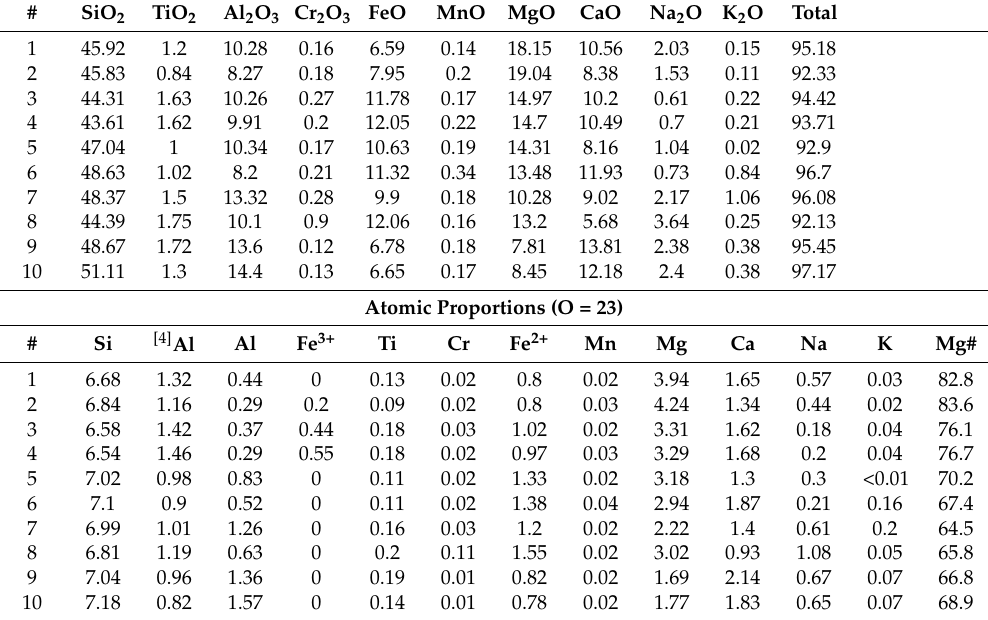
Table 4. Compositions of amphibole inclusions hosted by grains of platinum-group minerals in the Sisim placer zone, Eastern